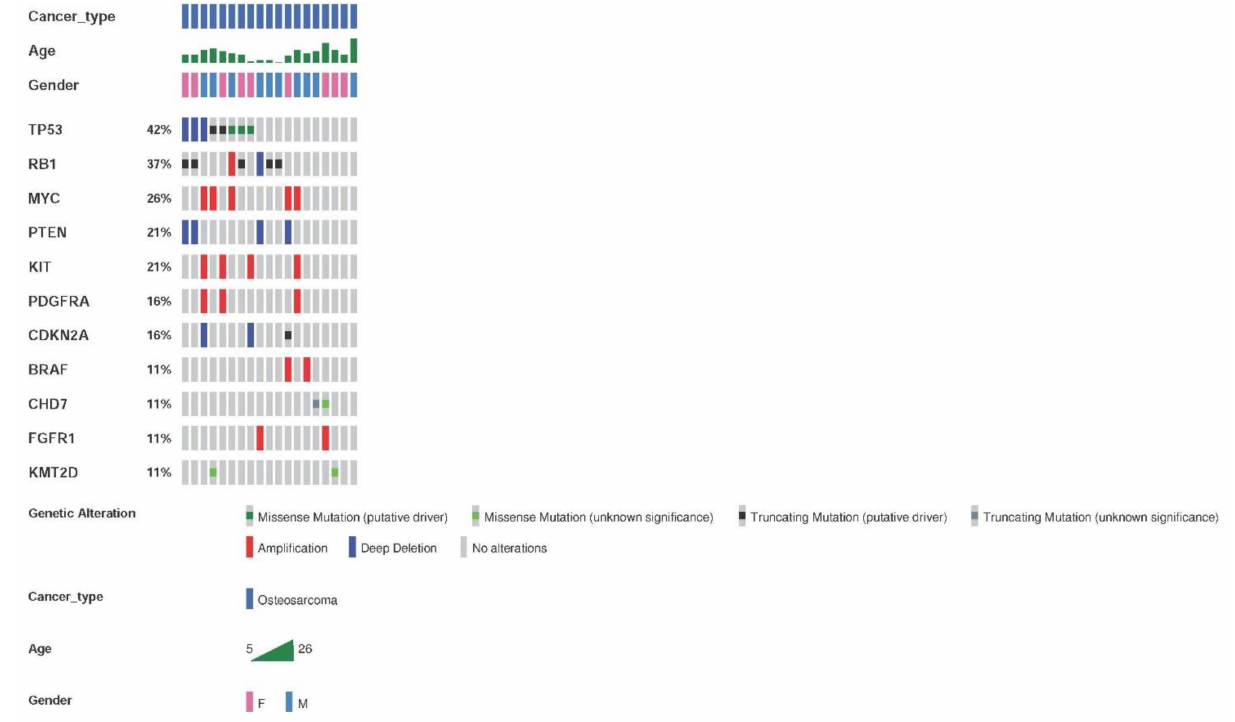
Figure 4. Most frequent genetic alterations in osteosarcoma patients. Genetic alterations, SNVs, indels, and fusions with a frequency ≥ 11% or two samples. Altered genes identified in less than two sarcoma samples were: ERBB3, GLI1, CDK4, NOTCH1, KDM6A, ASXL1, SMARCA4, DICER1, SMARCB1, CDK6 , IGF1R, NF2, TCF3, CDKN2B, ABL2, ARID1B, ARID1A, and rearrangements involving FGFR-KIAA1217, HMGA-LPP, KMT2C-PRKAG2, and SFPQ-EPS15